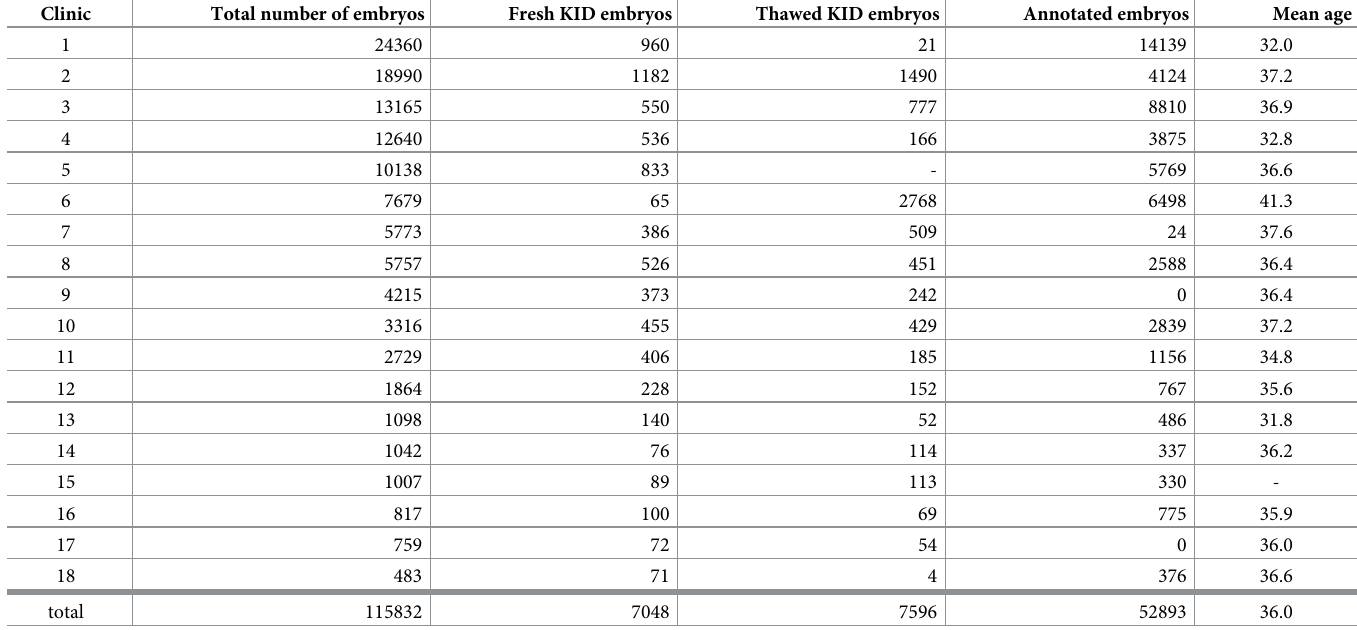
Table 1. Distribution of total number of embryos, fresh embryos and thawed embryos with known implantation data (KID), total number of annotated embryos and average female age.